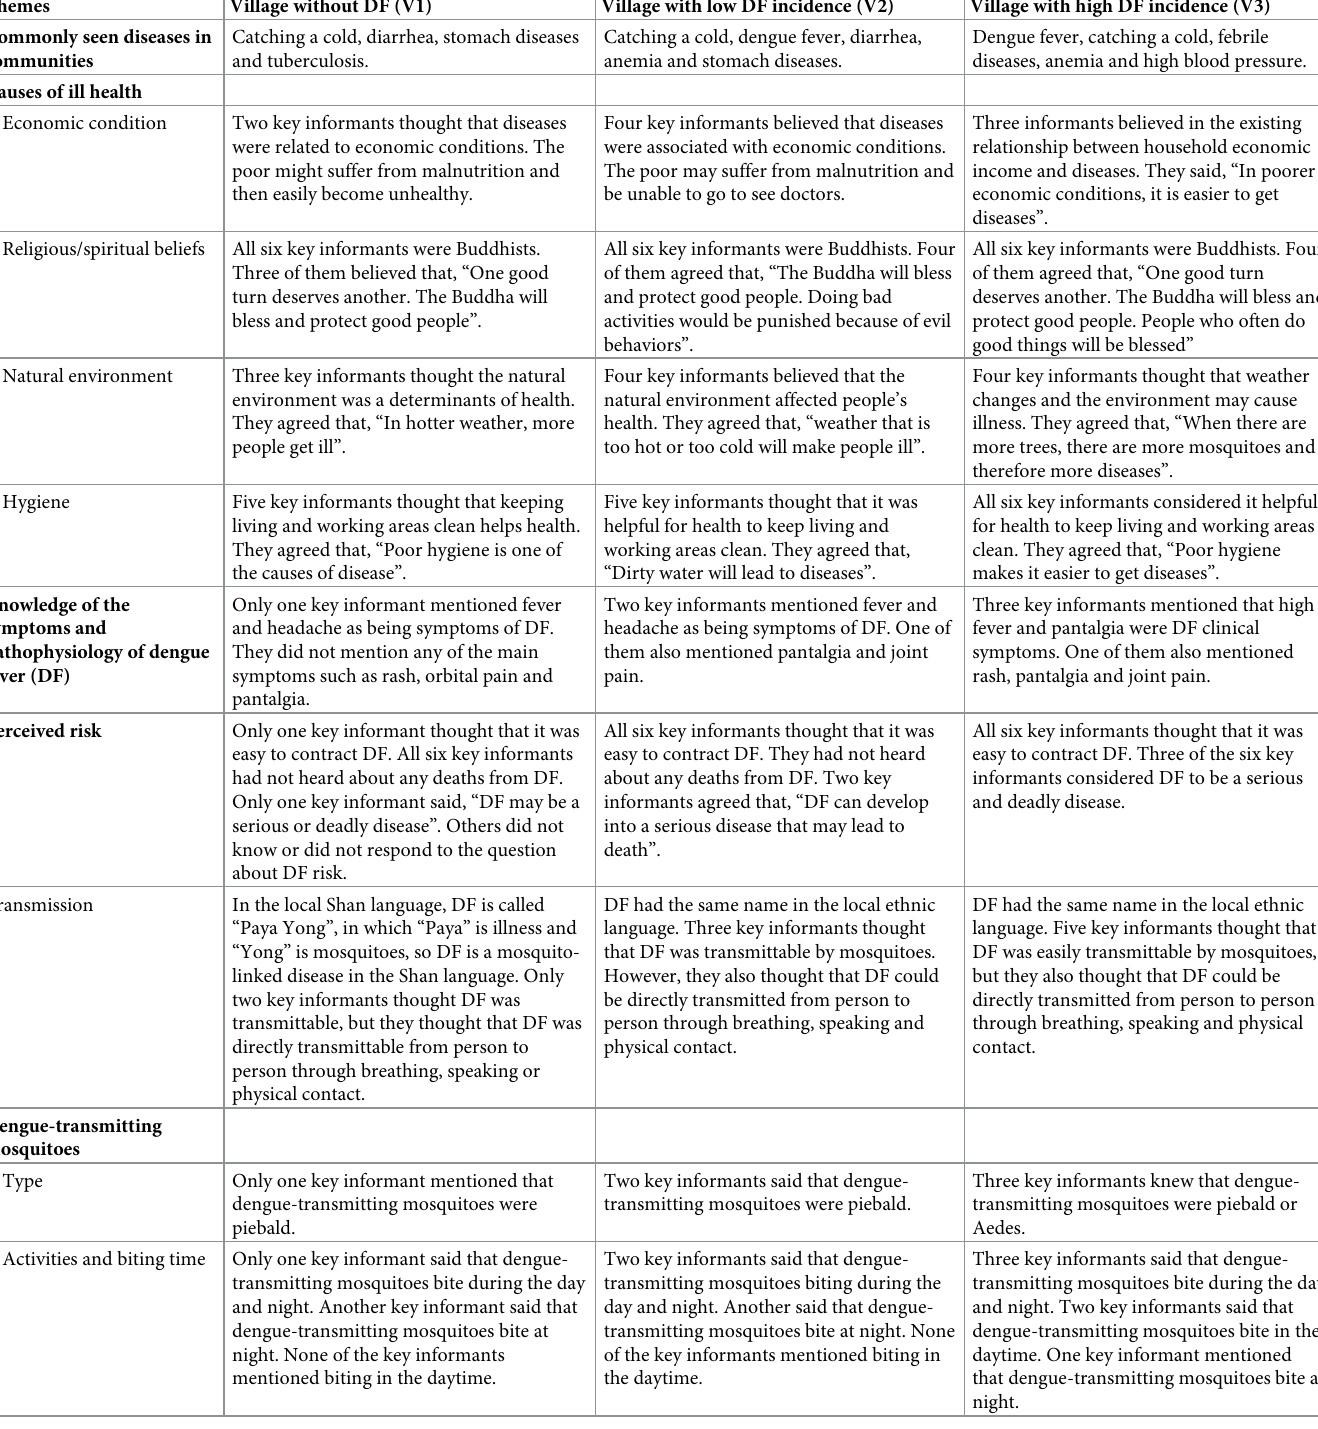
Table 2. Thematic points of the key informant’s beliefs, knowledge and perceptions regarding dengue fever in Eastern Shan Special Region IV, Myanmar.